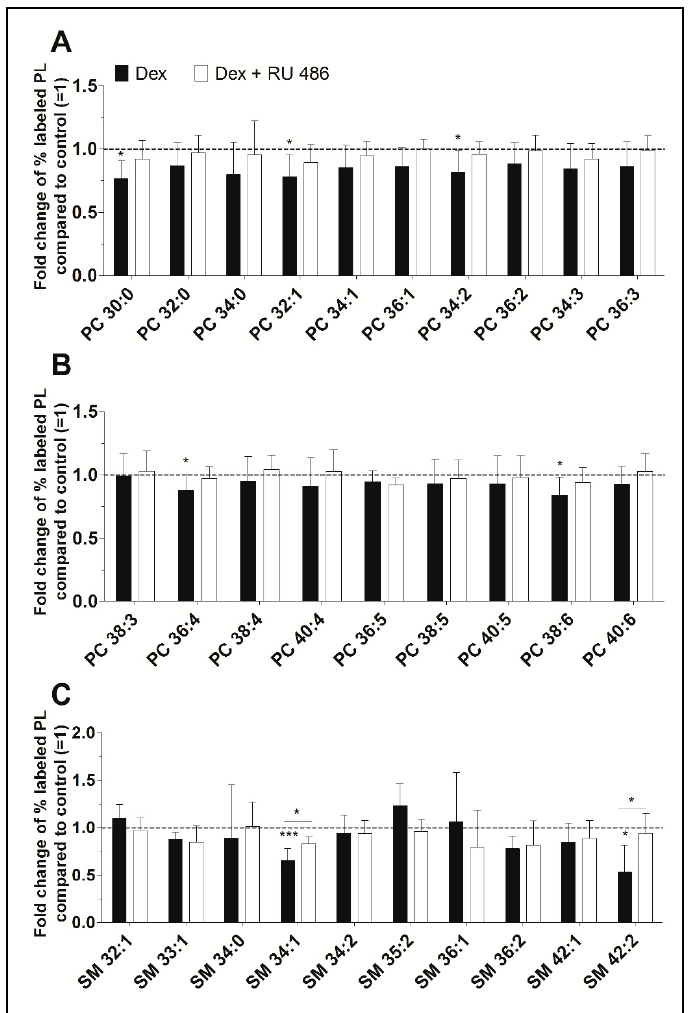
Figure 2. ( A , B ) The effect of dexamethasone on the synthesis of individual PC and ( C ) SM species as modulated by the glucocorticoid receptor antagonist RU 486. PL biosynthesis was monitored with ESI-MS/MS in the presence of 10 µM dexamethasone (Dex, black bars) alone or together with 1 µM RU 486 (white bars) for 16 h ( n = 5). The percentages of stable isotope-labeled PC species were calculated and then normalized as ratios of the corresponding untreated controls. As such, data are presented as means + SDs of the x-fold change of % labeled PL species compared to untreated controls (=1). * p ≤ 0.05, *** p ≤ 0.001. PC = phosphatidylcholine; SM = sphingomyelin.